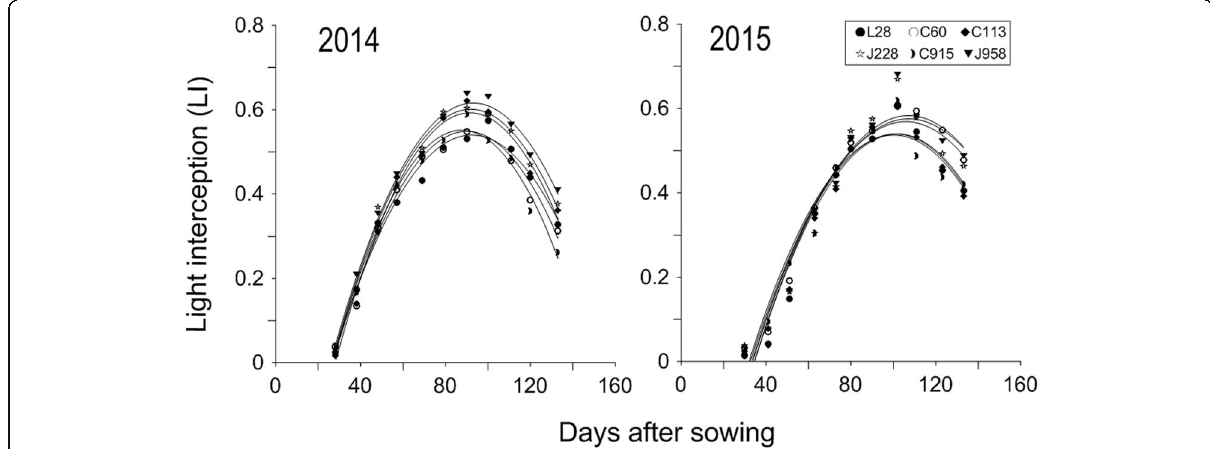
Fig. 1 LI of six different cotton cultivars with different plant types during the cotton growth periods in 2014 and